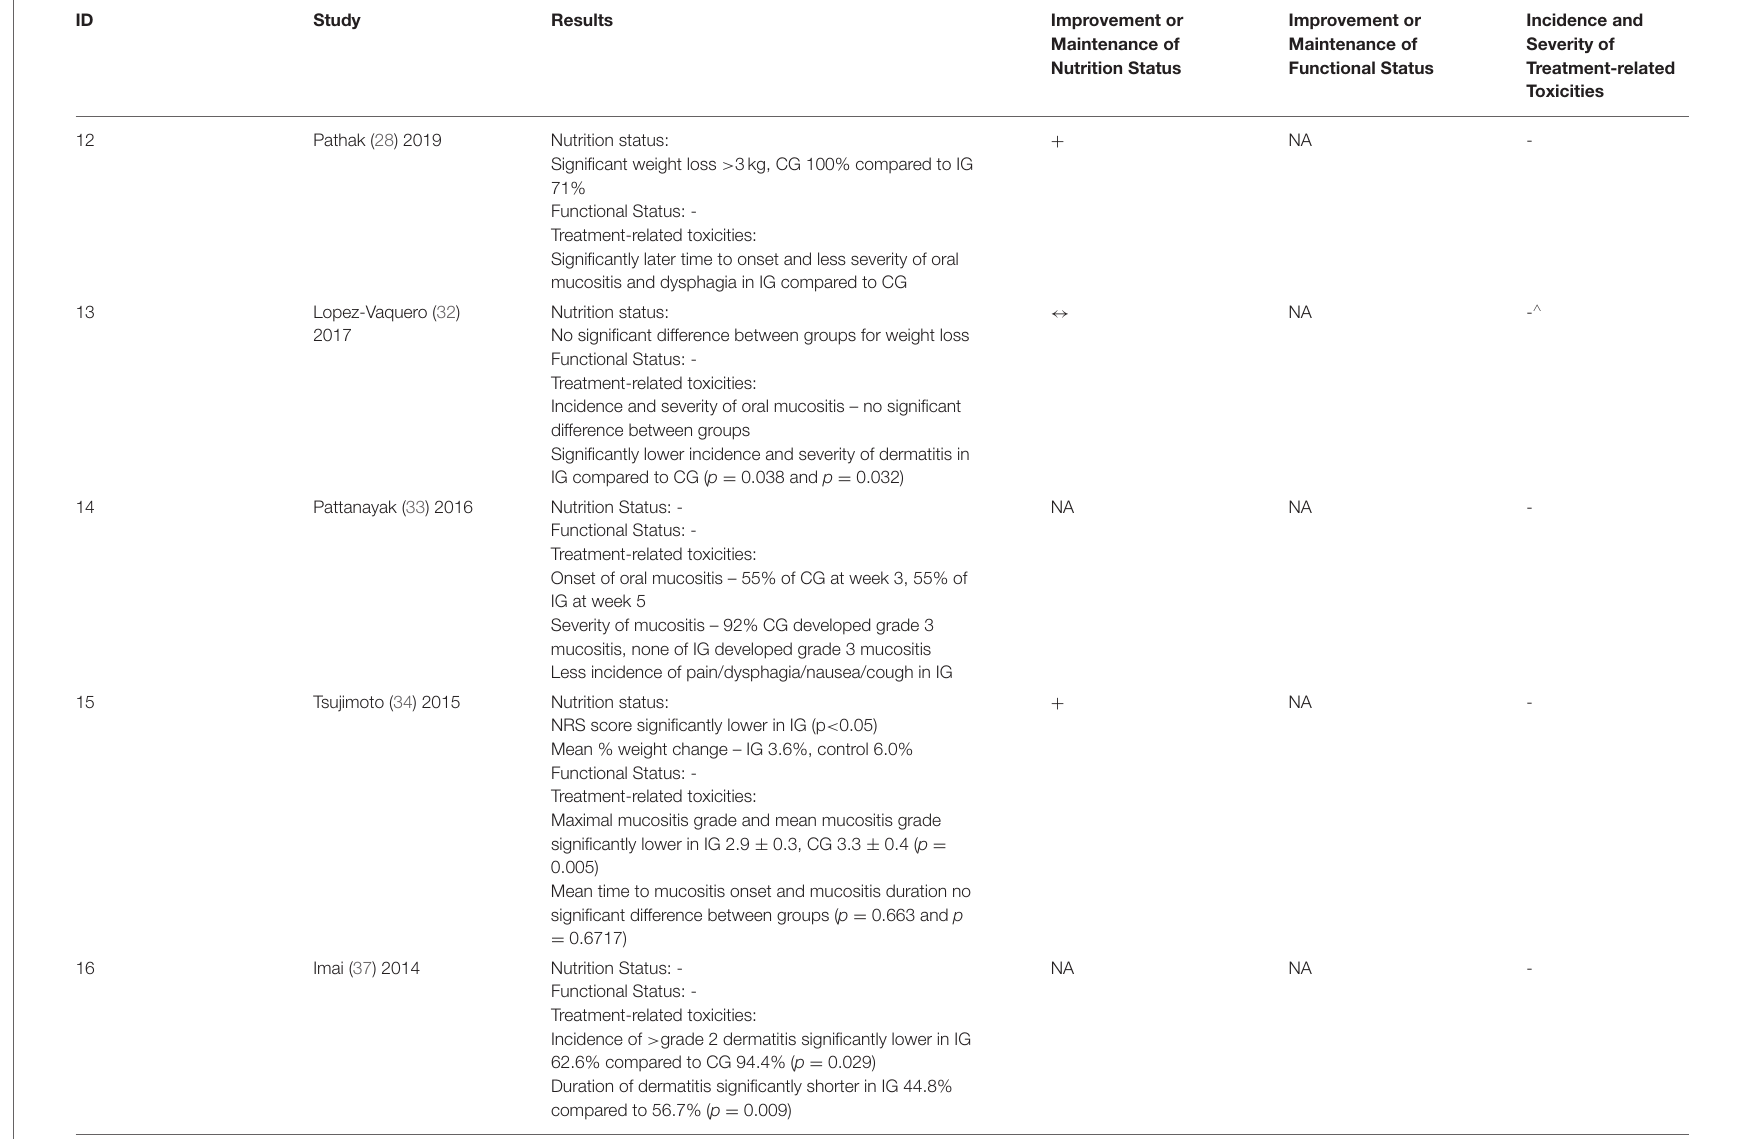
Nutrition Status: - Functional Status: - Treatment-related toxicities: Incidence of > grade 2 dermatitis significantly lower in